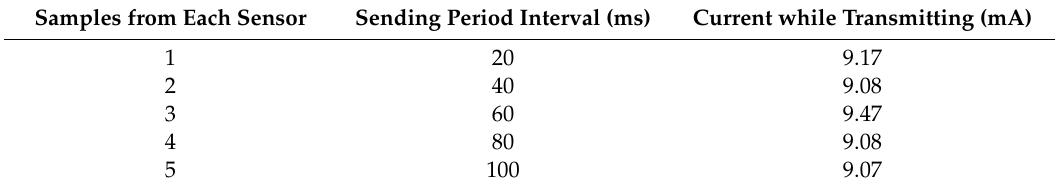
Table 2. Energy Consumption Analysis—Notifications Size, the best result is